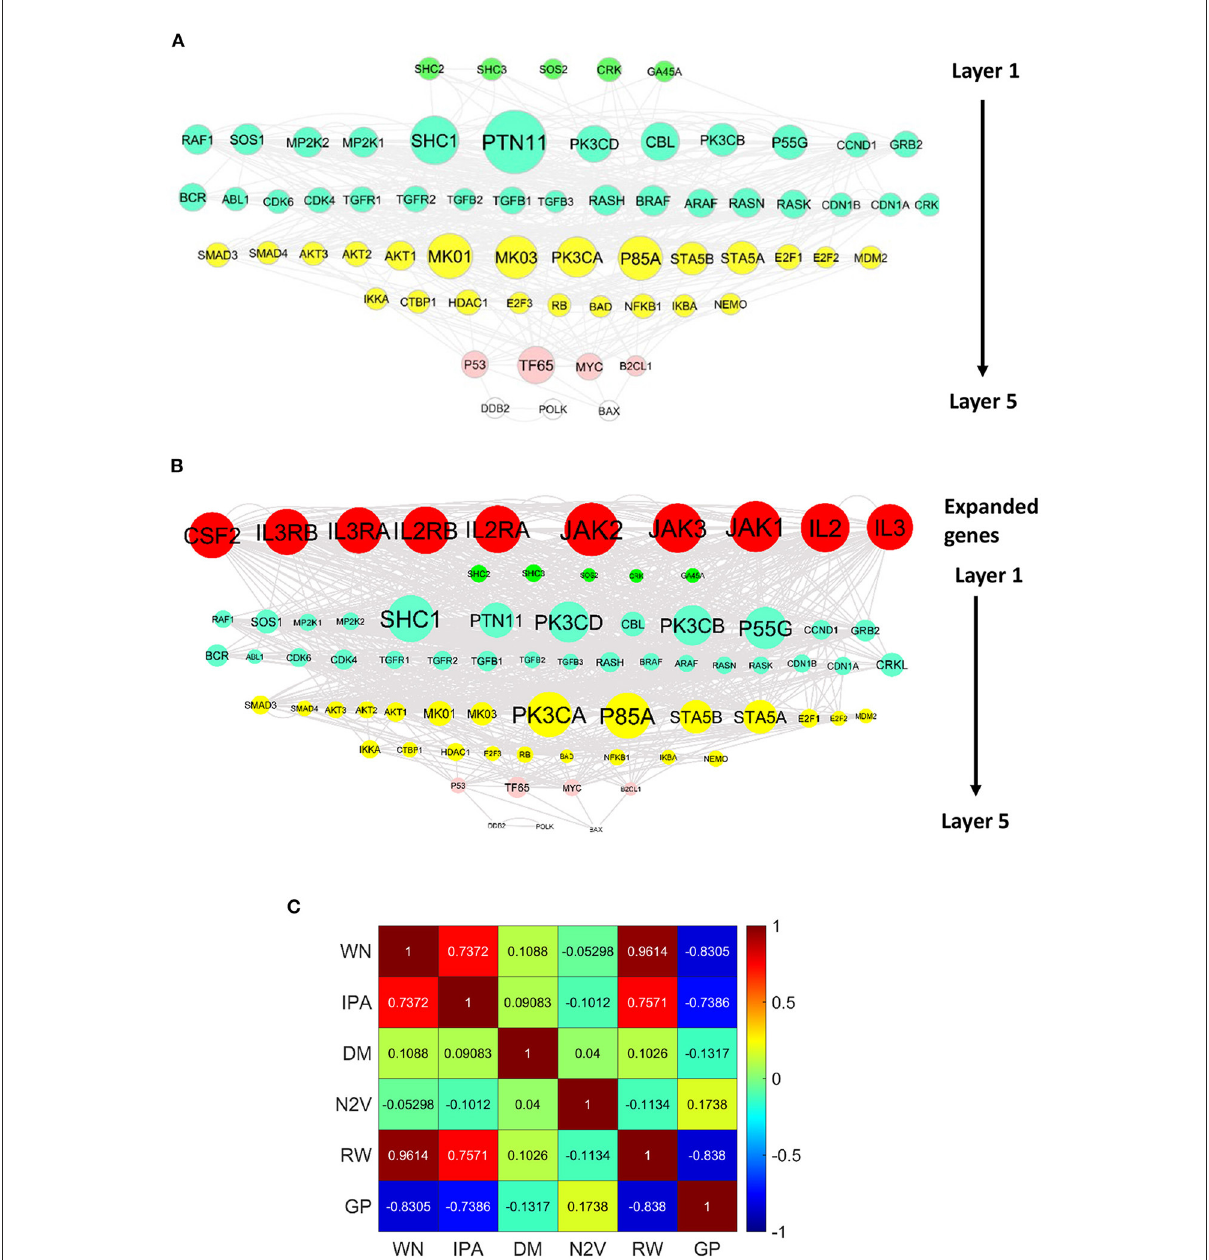
FIGURE6 WINNER upstream ranking and expansion can identify genes that are missing from established chronic myeloid leukemia (CML) networks. Genes in the KEGG CML pathways were distributed into layers via WINNER upstream, and genes that were missing from the networks were identified via WINNER expansion. Genes in the same layer are displayed in the same color, and the size of the node represents the WINNER score. (A) WINNER ranking without expansion. (B) WINNER ranking with expanded genes. (C) Correlation among WINNER (WN), Igenunity Pathway Analysis (IPA), DIAMOnD (DM), Node2Vec (ND), Random Walk (RW), and GenePANDA (GP) ranking.